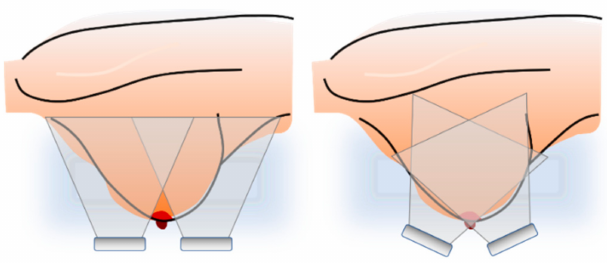
Figure 6. Limitation of the probe offset and the probe adjustment to cover object